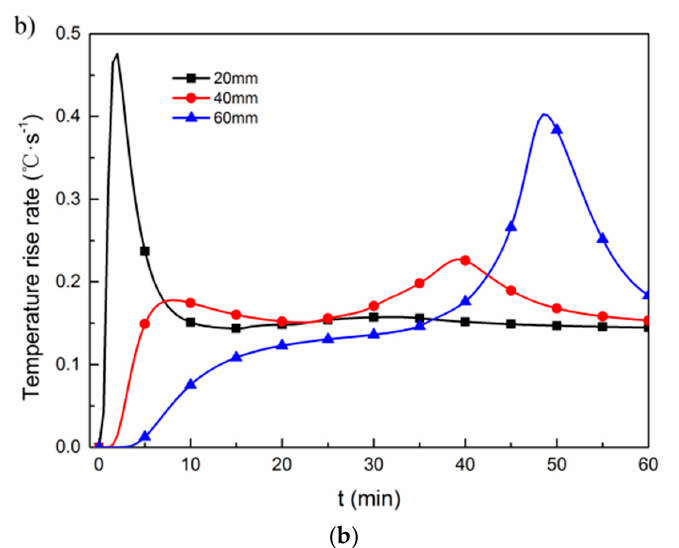
Figure 6. Effect of coal size on the temperature ( a ) and temperature rise rate ( b ) at center of coal particle, 10 °C/min.